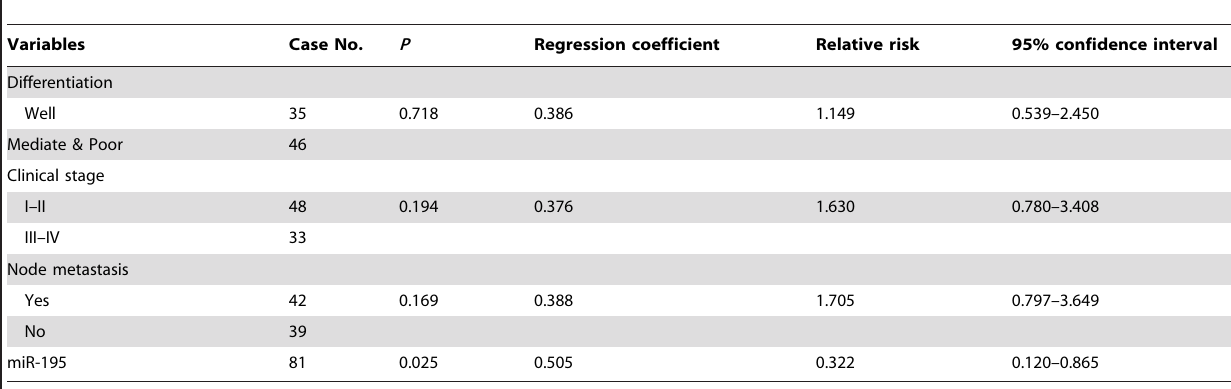
Table 2. Multivariable analysis of various prognostic variables in TSCC patients using Cox regression analysis.